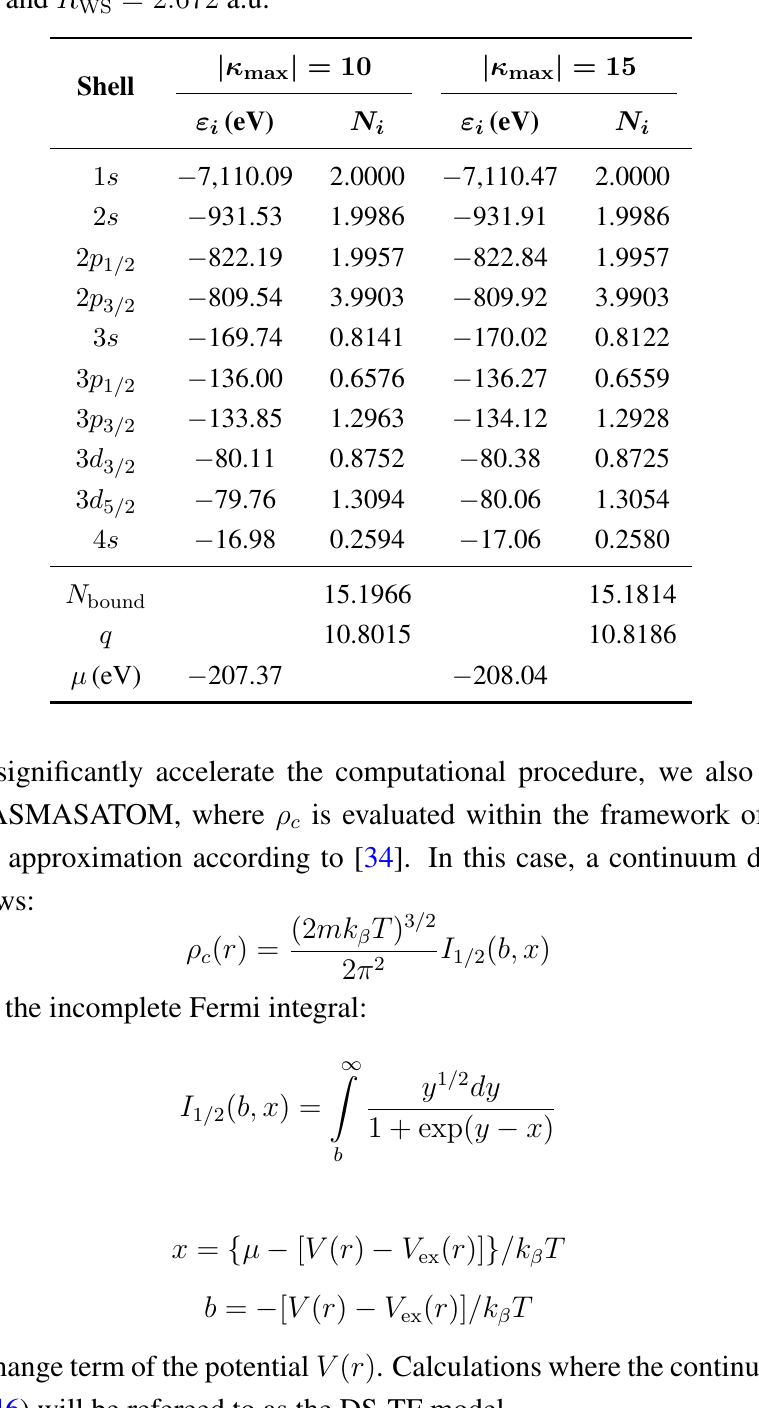
, occupation numbers N i = 2 . 672 WS